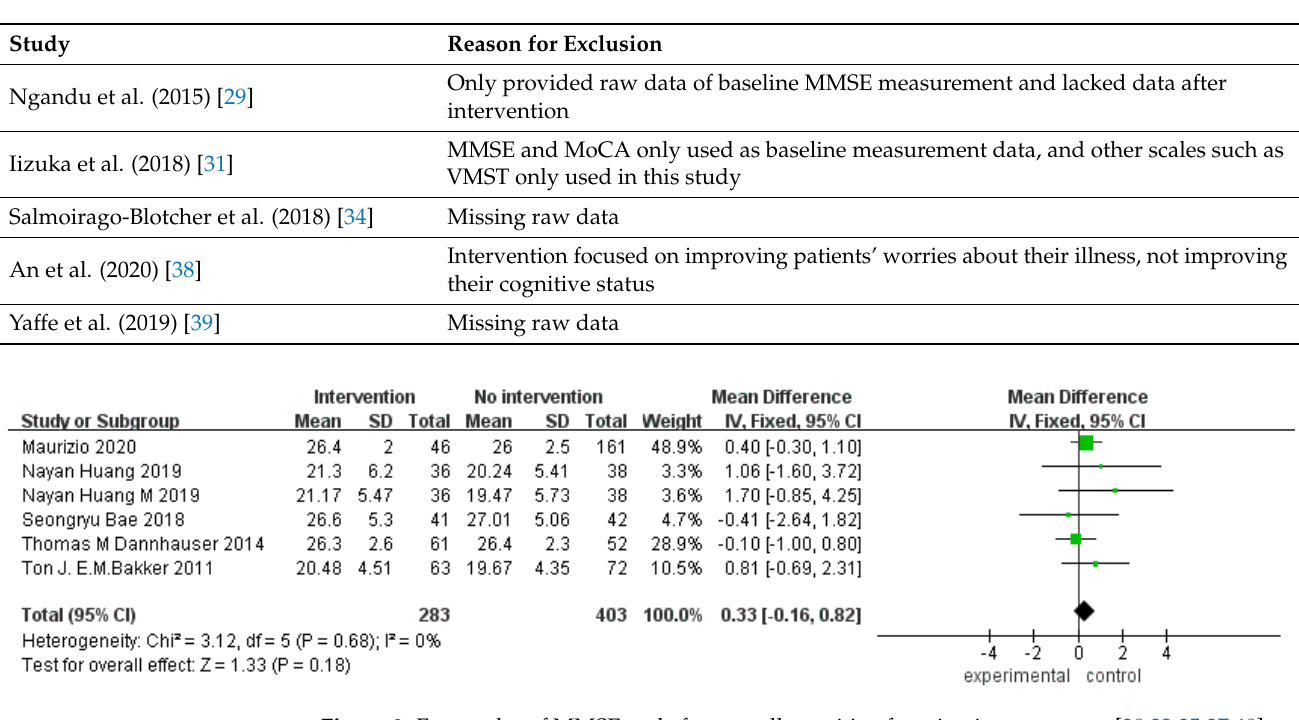
Figure 2. Evaluation of bias risk [29–40]. Table 2. Reasons for the exclusion of studies from the meta-analysis.